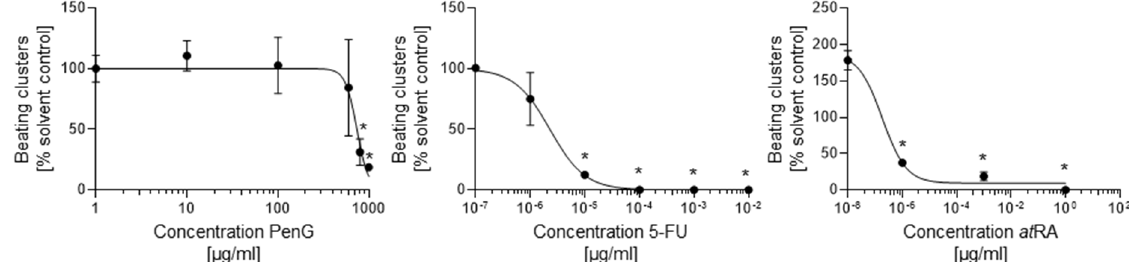
Figure 3. Treatment with embryotoxicants 5-FU and at RA impeded cardiomyocyte differentiation. hiPSCs were treated with different concentrations of 5-FU, at RA, or PenG and evaluated for differentiation inhibition by visually scoring the number of actively contracting cardiomyocyte clusters. Each data point represents the mean of three independent experiments ± SD. *: p < 0.05 = the lowest concentration significantly below the untreated control group as determined by One-Way ANOVA. hiPSC, human induced pluripotent stem cell; 5-FU, 5-fluorouracil; at RA, all-trans retinoic acid; PenG, penicillin G. Table 1. Comparison of mESC- and hiPSC-EST IC 50 and ID 50 values and embryotoxicity